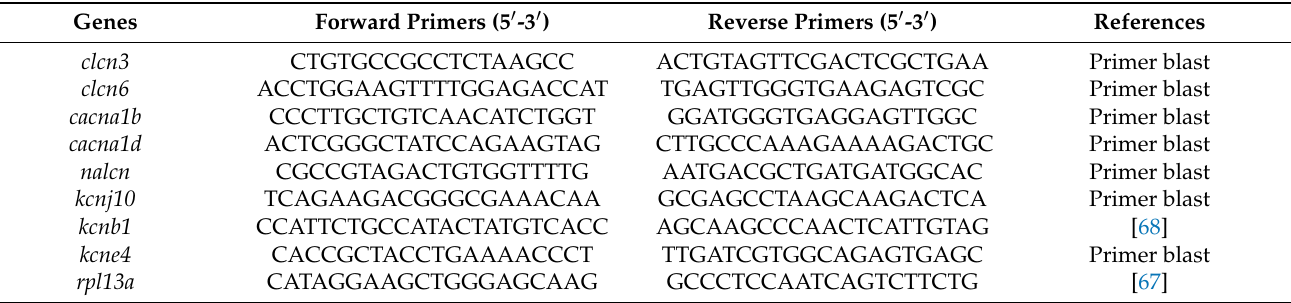
Table 2. Primers used to assess the expression of genes involved in voltage-dependant ion channels. Genes Forward Primers (5 (cid:48) -3 (cid:48) ) Reverse Primers (5 (cid:48) -3 (cid:48)